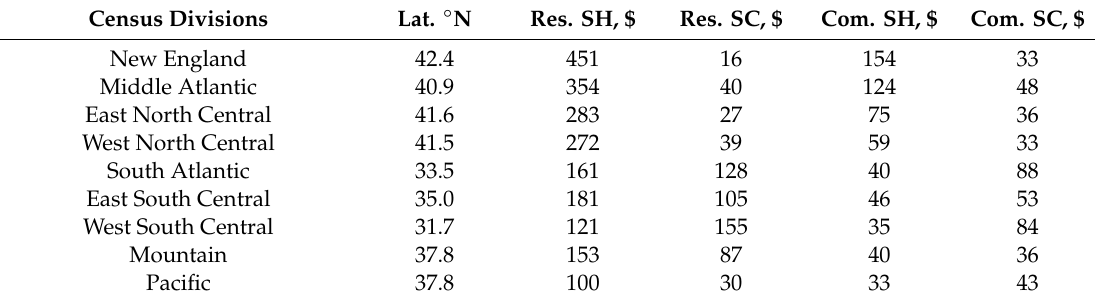
Table A2. Space heating and space cooling per capita energy expenditure, in 2010 US$, by US census division, for residential and commercial buildings, and the calculated latitude of the population centroid for